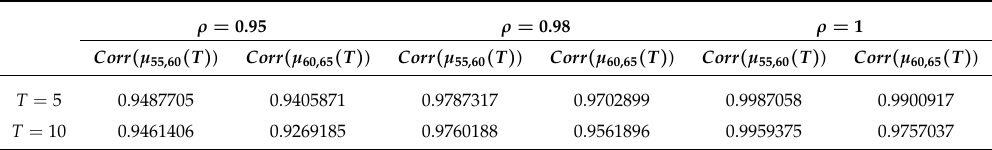
Table 4. Values of Corr ( µ y , z ( T )) .